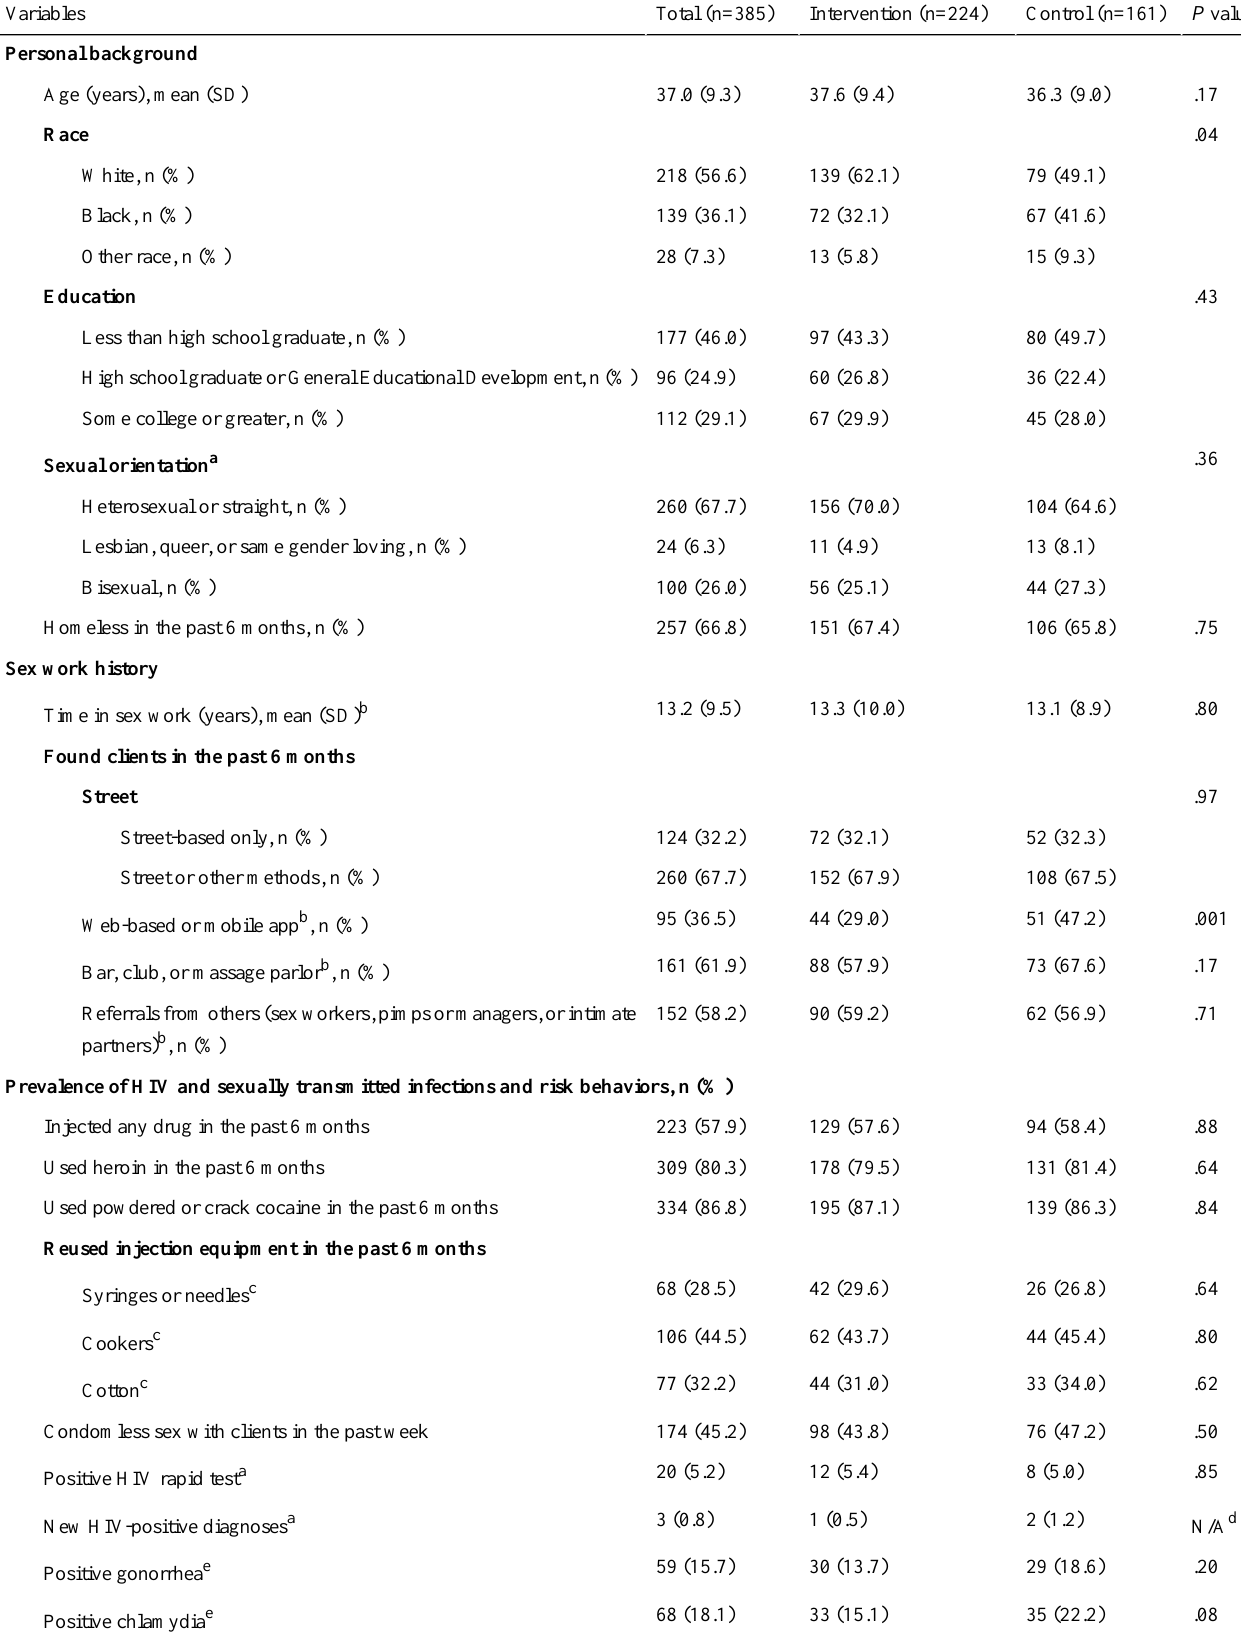
Table 2. Baseline characteristics of a sample of female sex workers in Baltimore, Maryland, recruited to the EMERALD (Enabling Mobilization, Empowerment, Risk Reduction, and Lasting Dignity) study